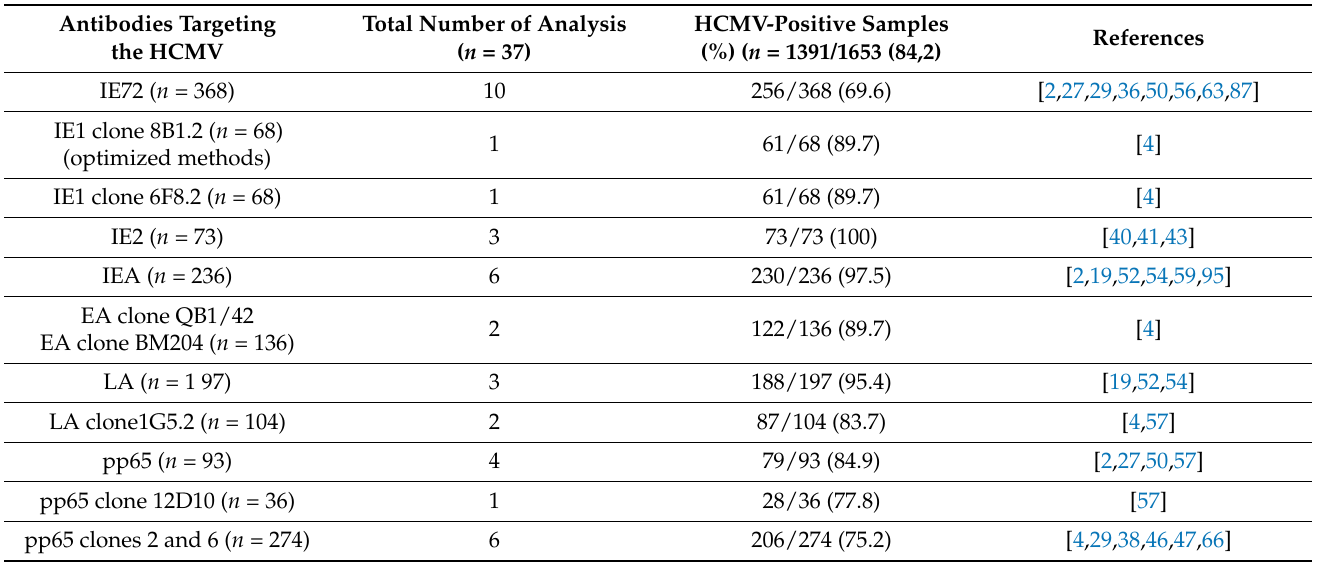
Table 4. Detection of the HCMV expression in GBM tissue specimens using different antibodies targeting HCMV proteins by immunohistochemical staining.